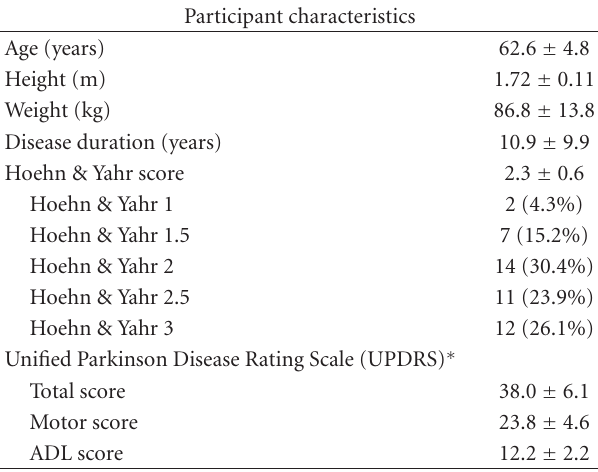
Table 1: Participant demographics and anthropometric data. Anthropometric data is presented as mean ± standard deviation. Hoehn and Yahr classification is presented as the actual number of subjects and the percentage of the total (percentage does not add to 100% due to